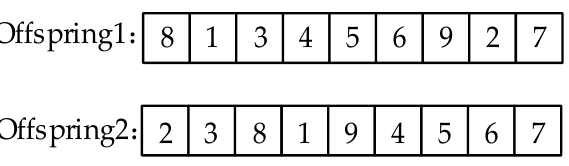
Figure 7. The process of extracting proto-child by Order Crossing Operator.